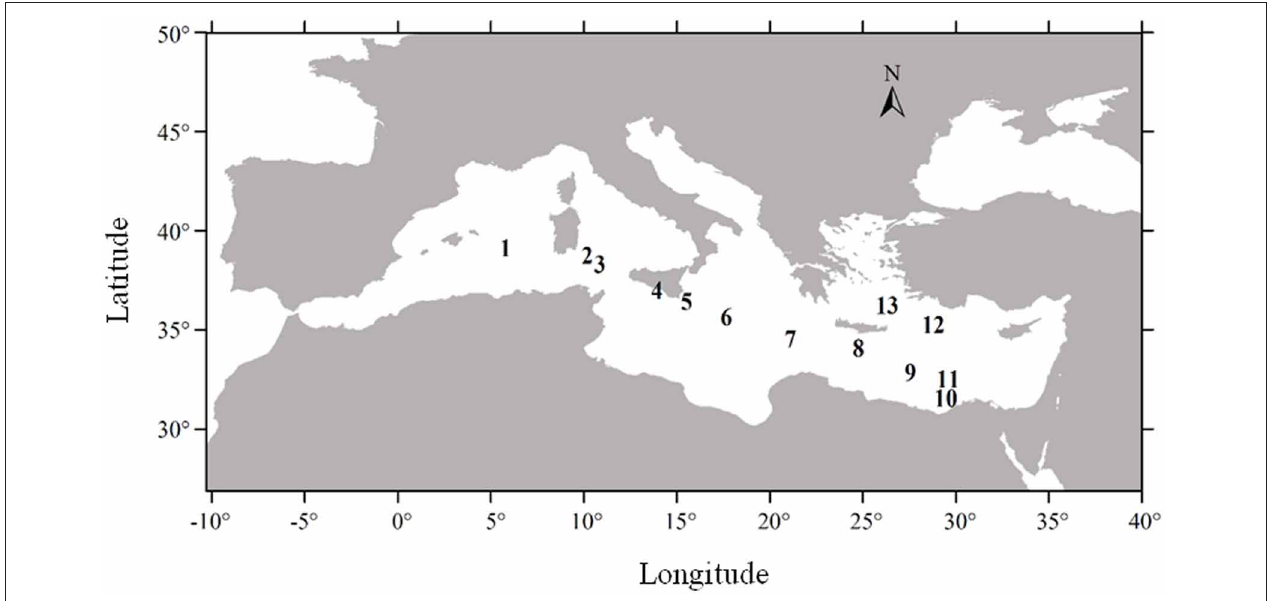
FIGURE 1 | Location of the thirteen stations of the